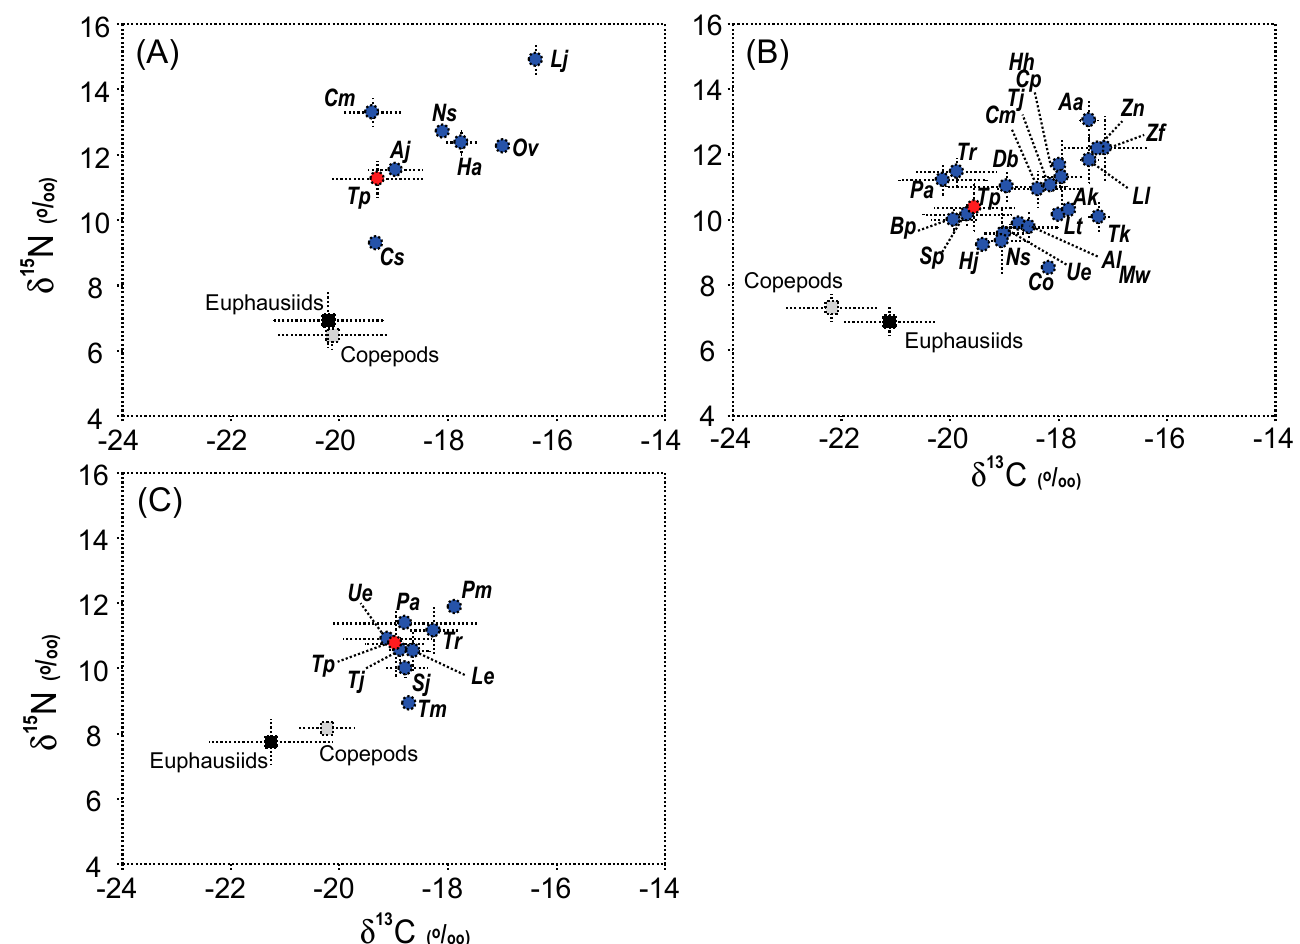
Figure 5. Dual isotope plots of δ 13 C and δ 15 N values of zooplankton (black squares, euphausiids; gray squares, copepods), common squid Trichiurus japonicus (red circles), and other fishes (blue circles) in the South Sea of Korea during February (winter, ( A )), May (spring, ( B )), and August (summer, ( C )) 2021. Values are presented as mean δ 13 C and δ 15 N (‰ ± 1 SD). Species codes are shown in Table 2. Table 2. Mean δ 13 C and δ 15 N values and trophic position (TP) of common squid Todarodes pacificus and other fish consumers collected during February, May, and August 2021 in the South Sea of Korea (#104, #106, #111, and #224). Data represent means ± 1 SD.